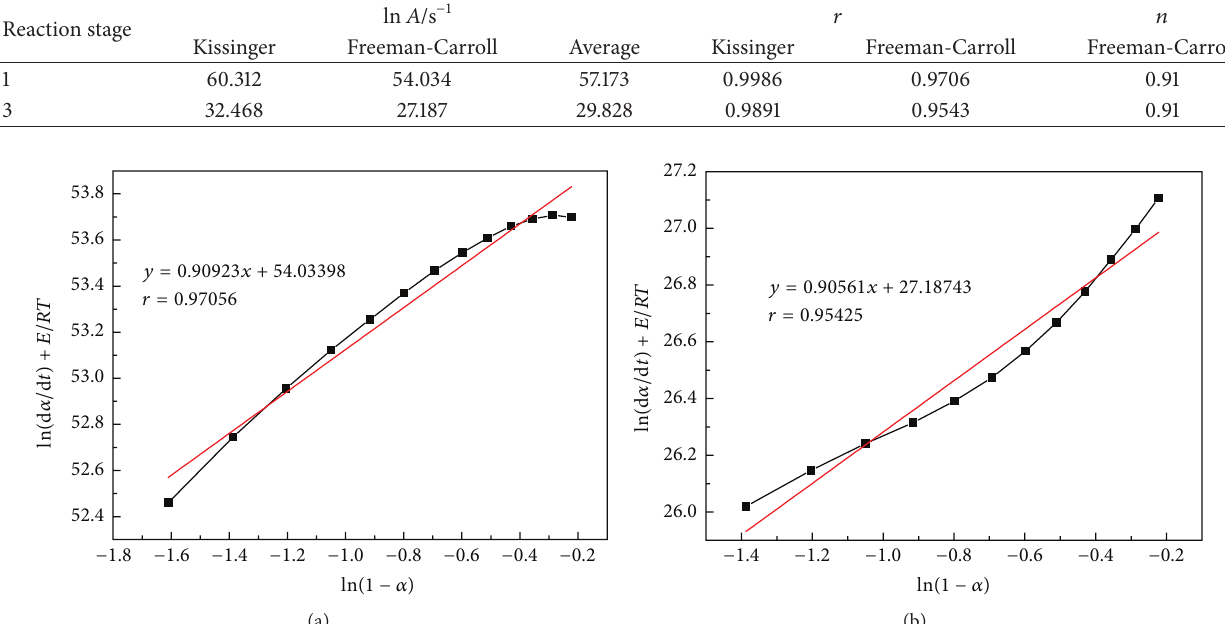
Figure 7: Curves of ln ( d 𝛼/ d 𝑡) + 𝐸/𝑅𝑇 versus ln (1 − 𝛼) at the first (a) and the third (b) stages of the thermal decomposition.